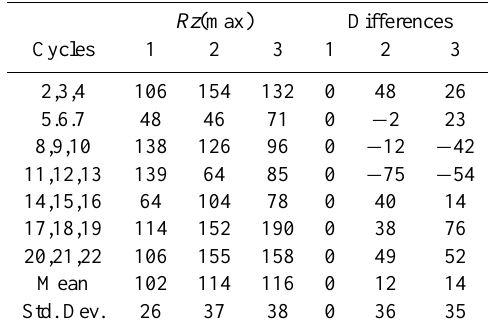
Table 4. Rz (max) values for 3-cycle